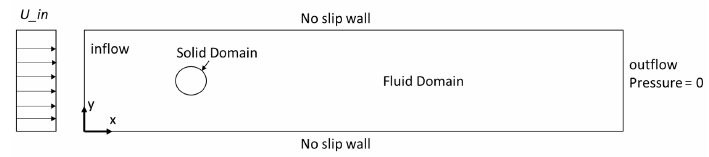
Figure 3. Domain and boundary conditions for vortex analysis.